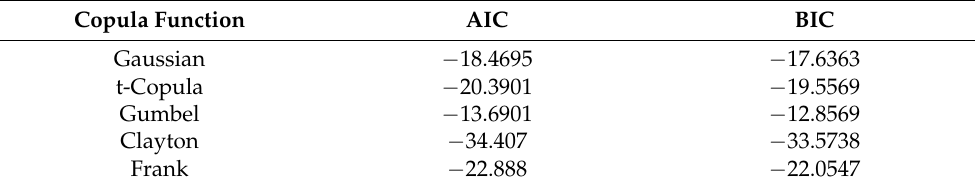
Table 3. Calculation results of AIC and BIC.